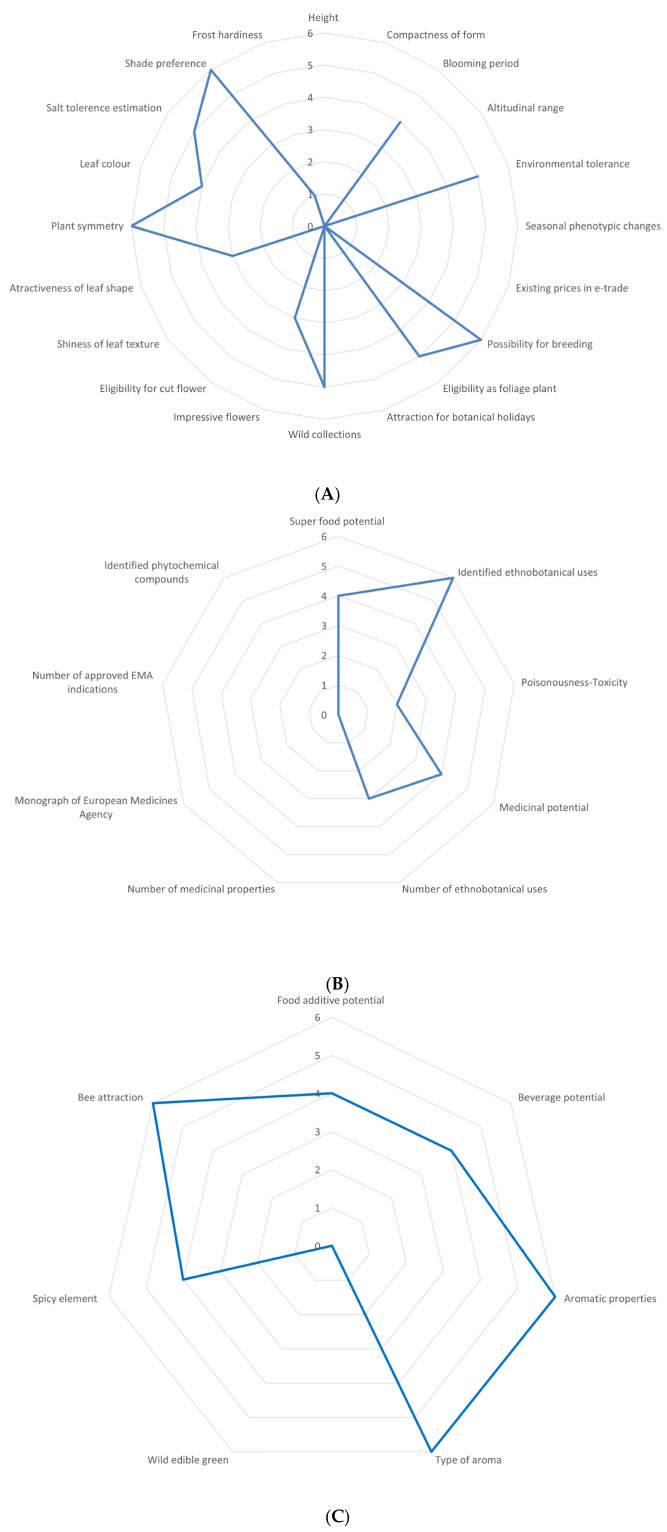
Figure 3. Multifaceted evaluation of Teucrium luteum subsp. gabesianum in different sectors of economy with obtained scores for: ( A ) 20 ornamental-horticultural attributes resulting in 44.16% of the optimum possible score [20]; ( B ) Nine medicinal-cosmetic attributes reaching 35.19% of the optimum possible score [18], and ( C ) Seven agro-alimentary attributes providing 71.43% of the maximum possible score